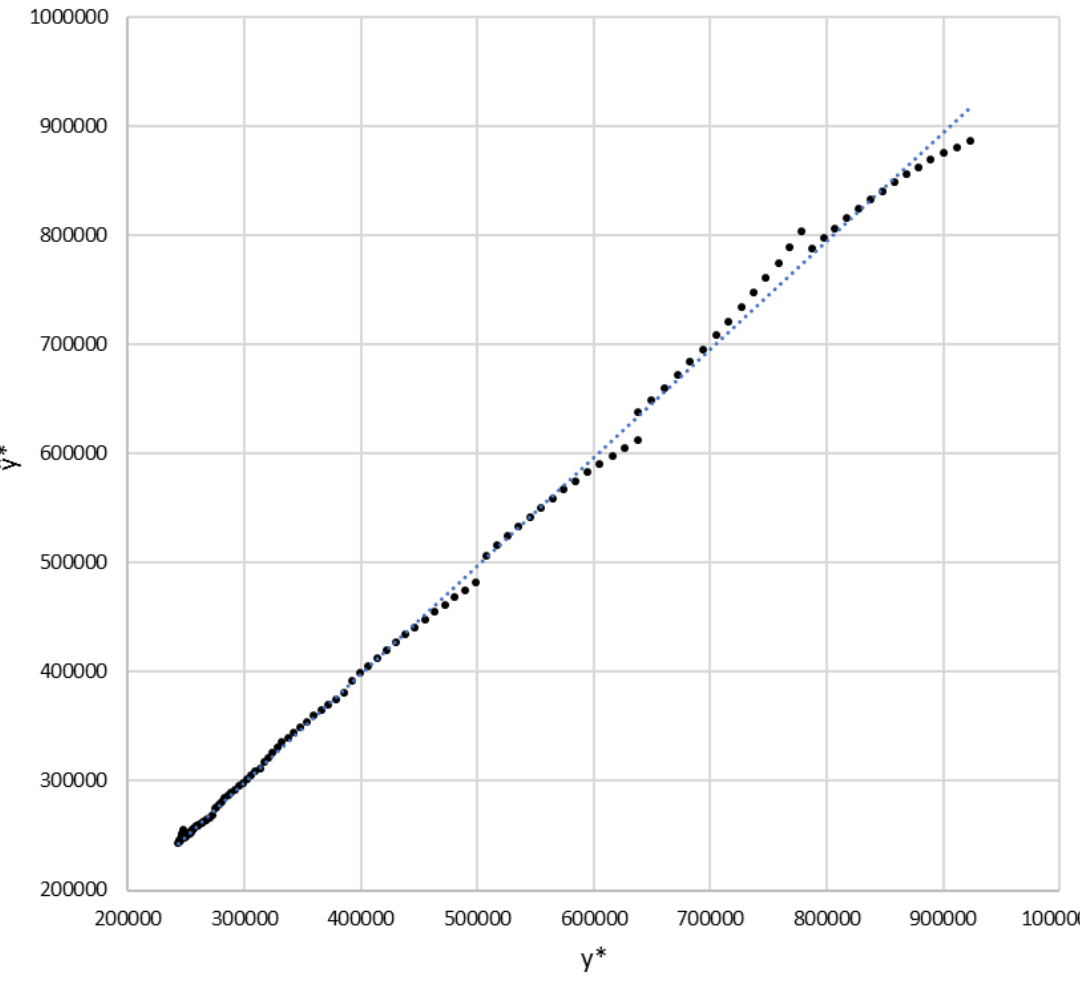
Figure 6. Arrays of observed and forecasted values between 15 June and 17 October ( ˆ y ∗ vs. y ∗ ). As expected, in each of the sections of the predictive curves, increasing x increases the relative standard errors of prediction. This can be seen very well in Figure 7, where ( y ∗ − ˆ y ∗ ) e r = is plotted versus x. We also observed that between x = 127 (29 June) and y ∗ x = 191 (1 September), the relative errors are in the range of − 0.83% to 1.48%, and therefore, all the observed values fall between the favorable and unfavorable scenario. This fact will be interpreted